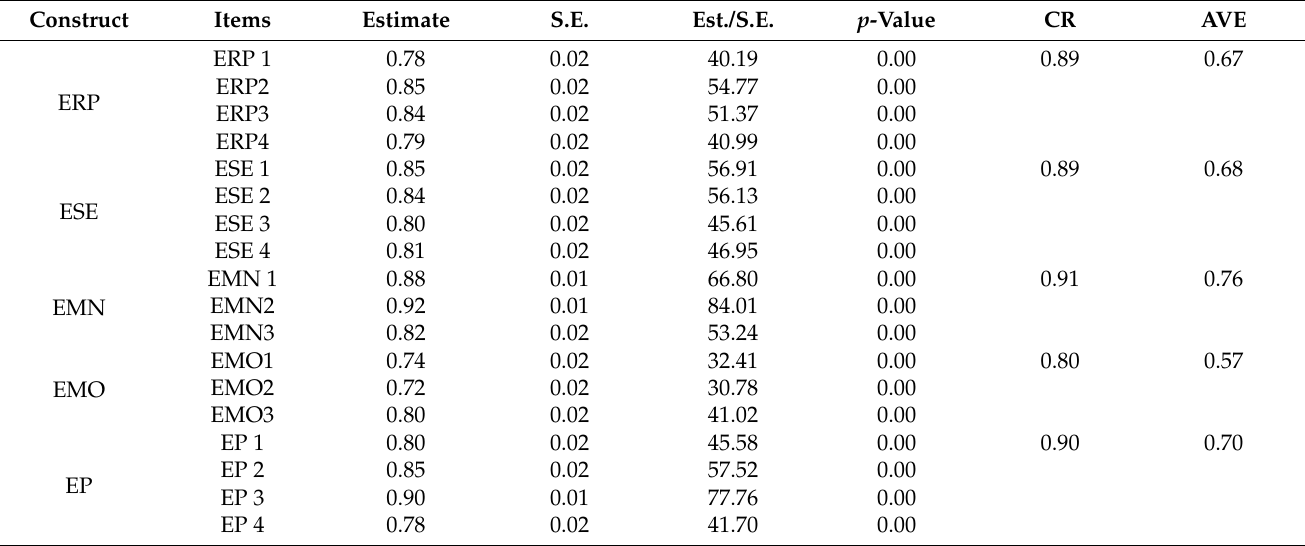
Table 1. The Factor Loadings, CR, and